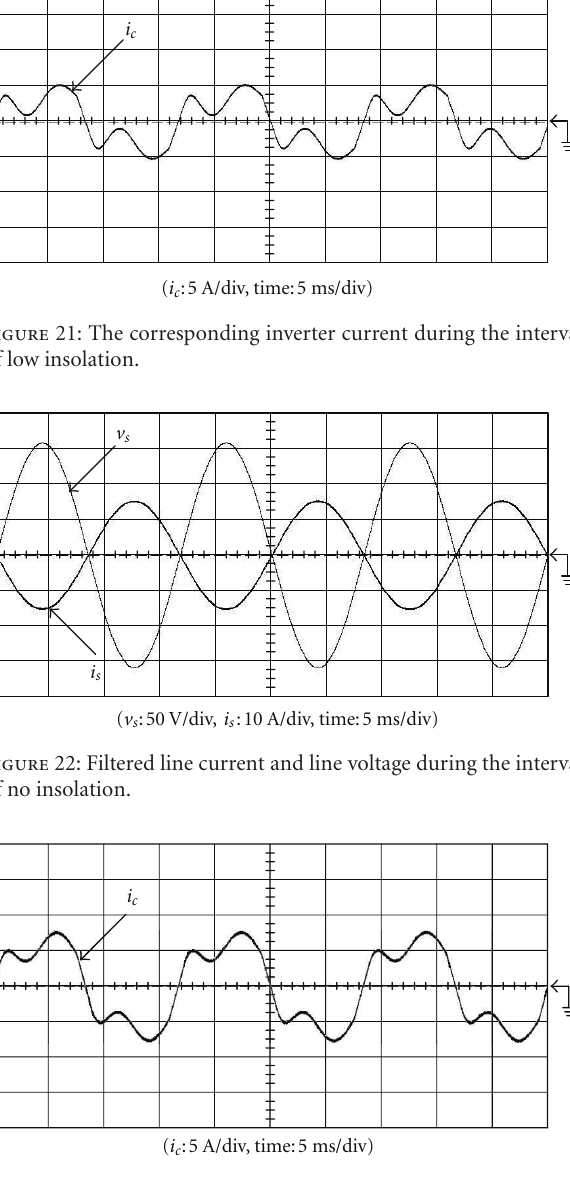
Figure 23: The corresponding inverter current during the interval of no insolation.